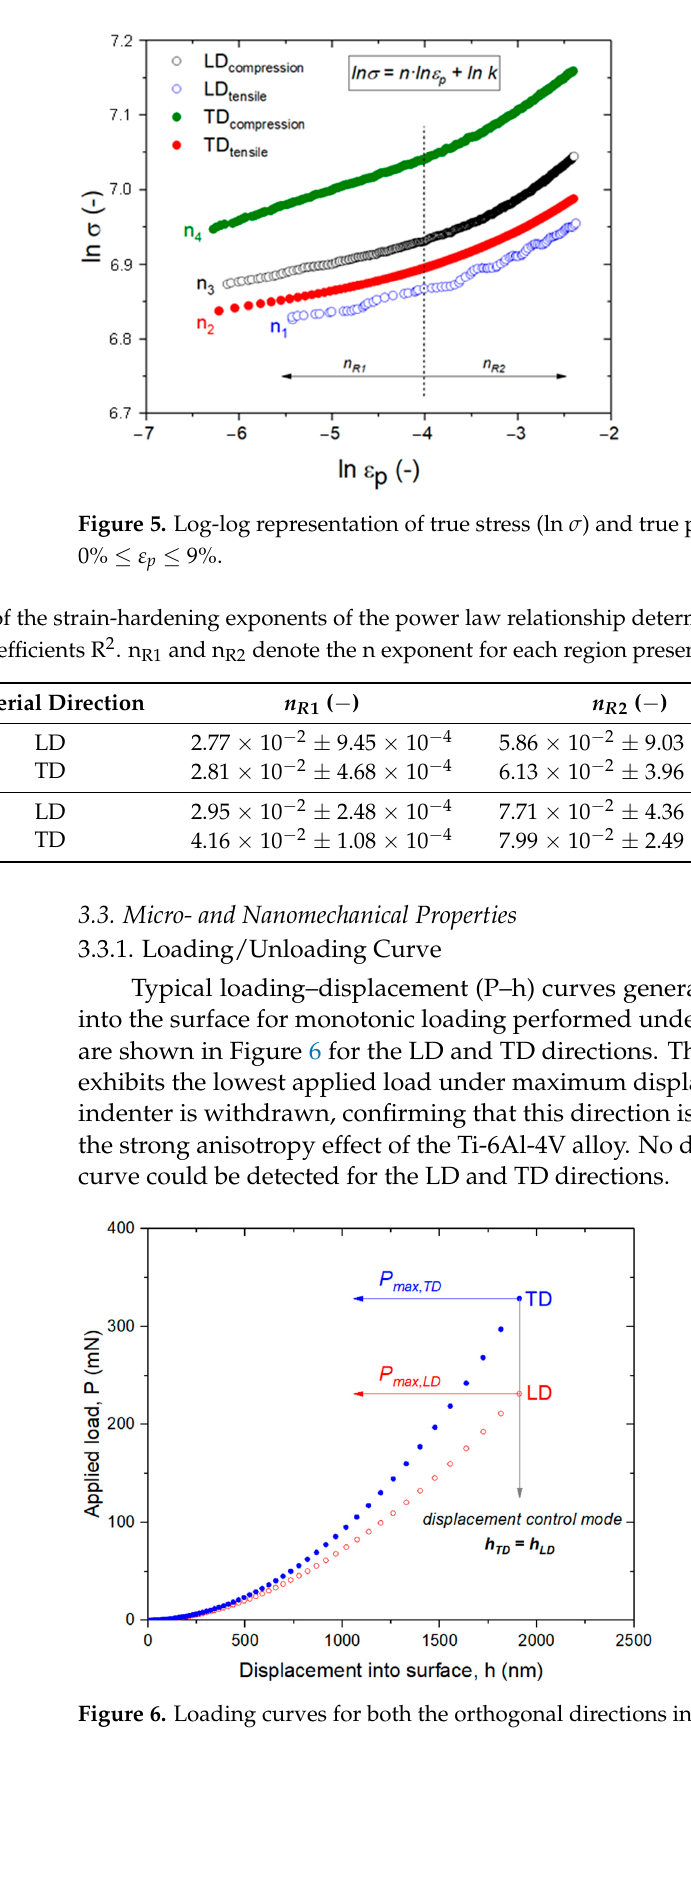
Figure 6. Loading curves for both the orthogonal directions investigated here (LD and TD).